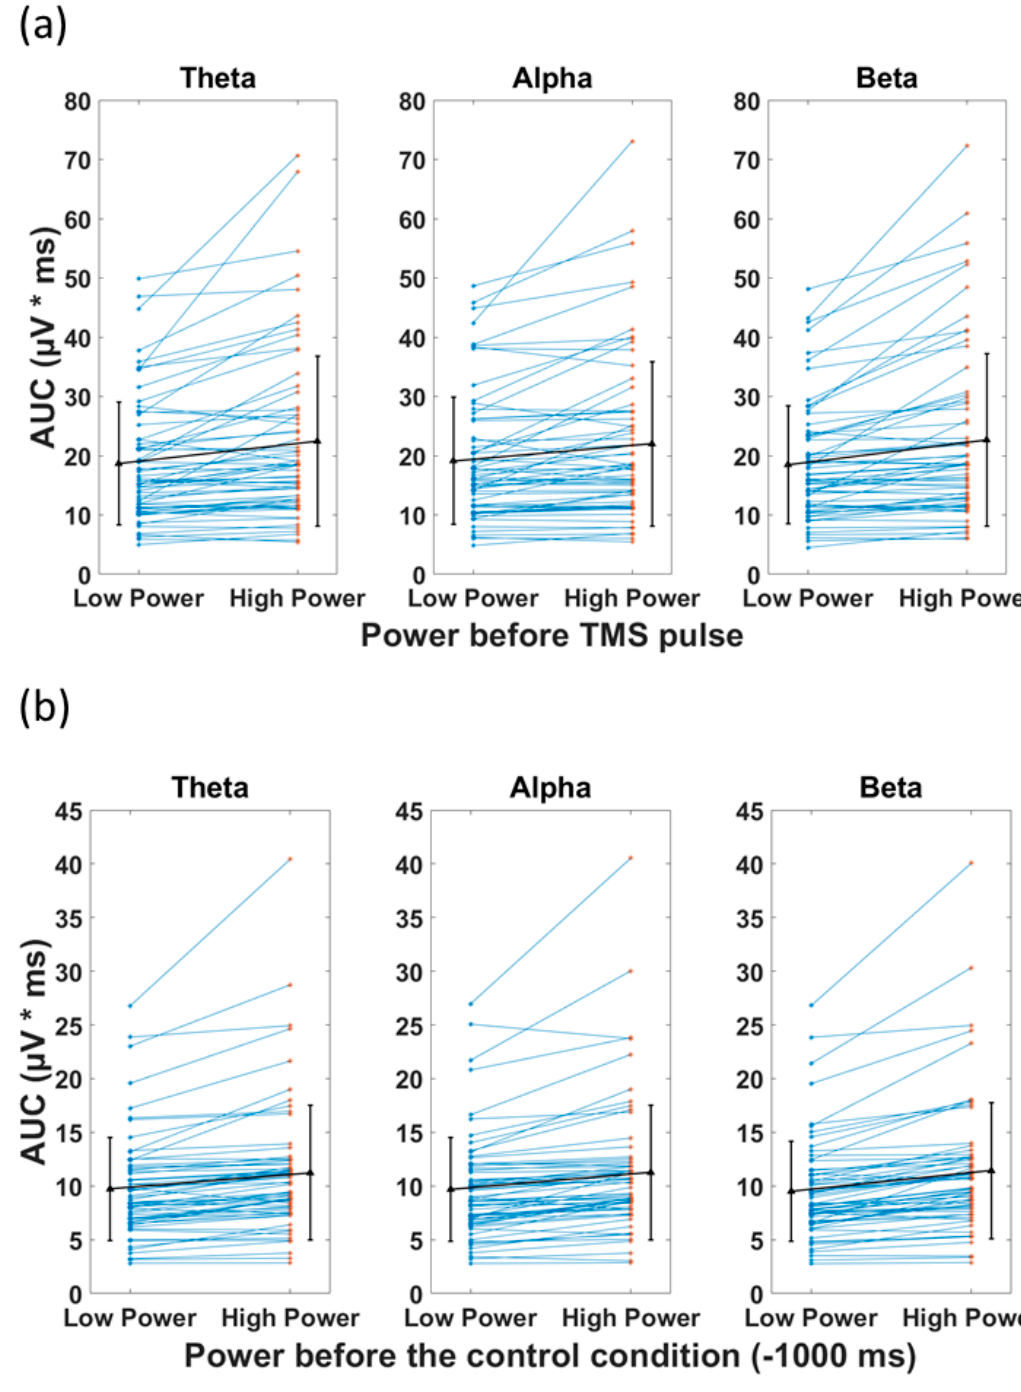
Figure 6. Effect of power of ongoing EEG oscillation on single-trial TMS-EEG response measured by area under the curve (AUC) after TMS pulse and in the Control condition with mean and standard deviation also shown (black). ( a ) Mean rectified TMS-evoked EEG activity, measured by area under the curve (AUC (TMS) ) for low power and high power over the three frequency bands of theta, alpha, and beta in healthy group. ( b ) Comparison of the area under the curve for the control condition (AUC (Control) ) for low power and high power over the three frequency bands of theta, alpha, and beta. High power resulted in significantly larger AUC ( p < 0.001) compared with low power, both in TMS and control conditions in theta, alpha, and beta frequency